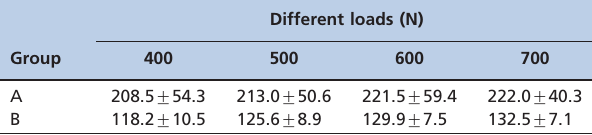
Table 4 - Different loading-axial stiffness of the pelvis in the sitting position (x ¡ s